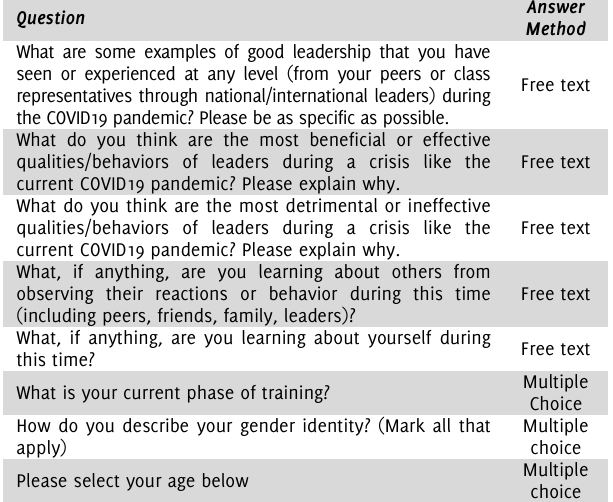
Table 1 . Free Response and Demographic Questions Surrounding Students’ Views of Good and Poor Leaders in a Pandemic at the University of Michigan Medical School.